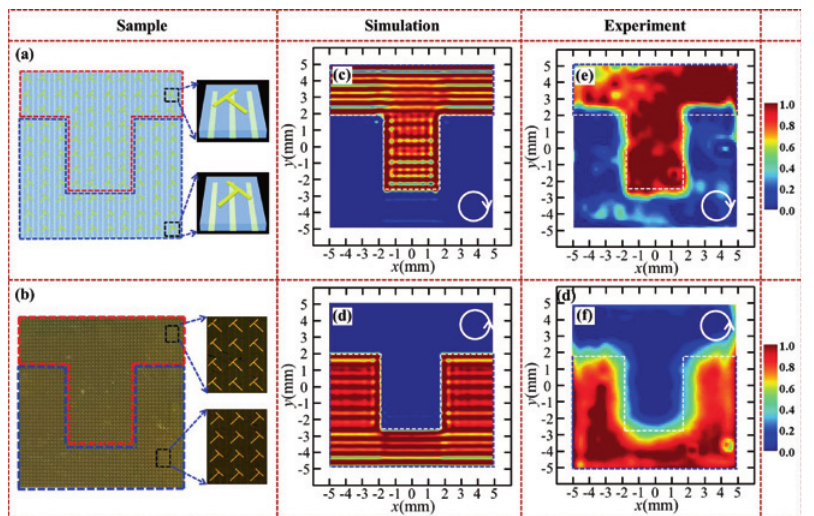
Figure 5: Helicity-dependent imaging. (a) and (b) Schematic and optical image of the imaging sample. (c) and (d) The simulated electric field distributions ( | E | 2 ) of the helicity-dependent sample under the illumination of RCP and LCP THz waves. (c) and (d) The measured results when the helicity-dependent sample is embedded in the left and right focal points,